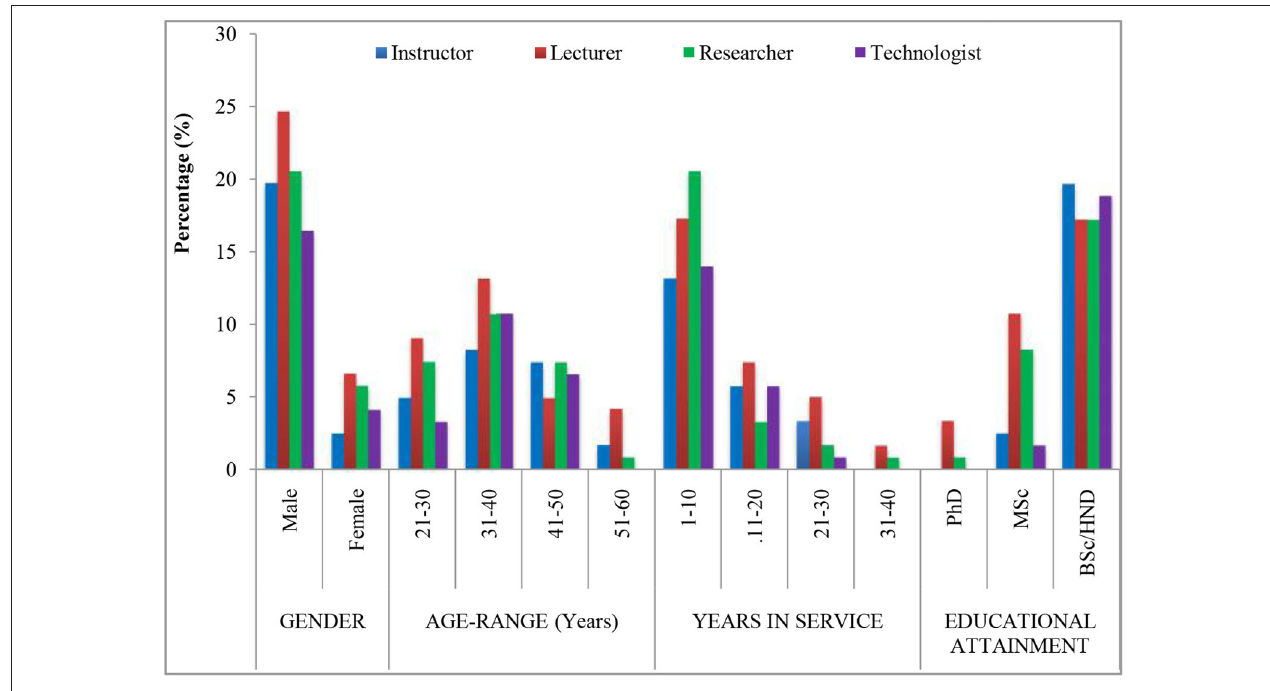
FIGURE 1 | Demographic characteristics of respondents.